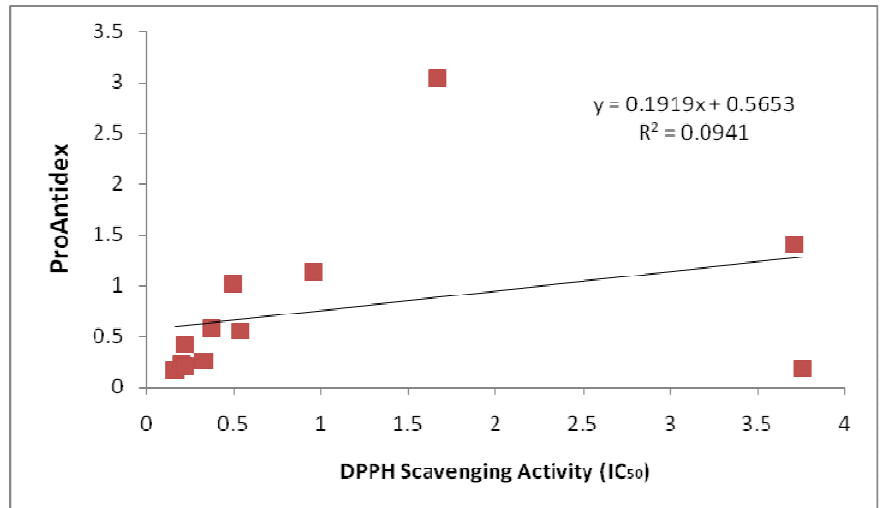
Figure 3. Correlation between ProAntidex and DPPH scavenging activity of aqueous extracts that we used in this